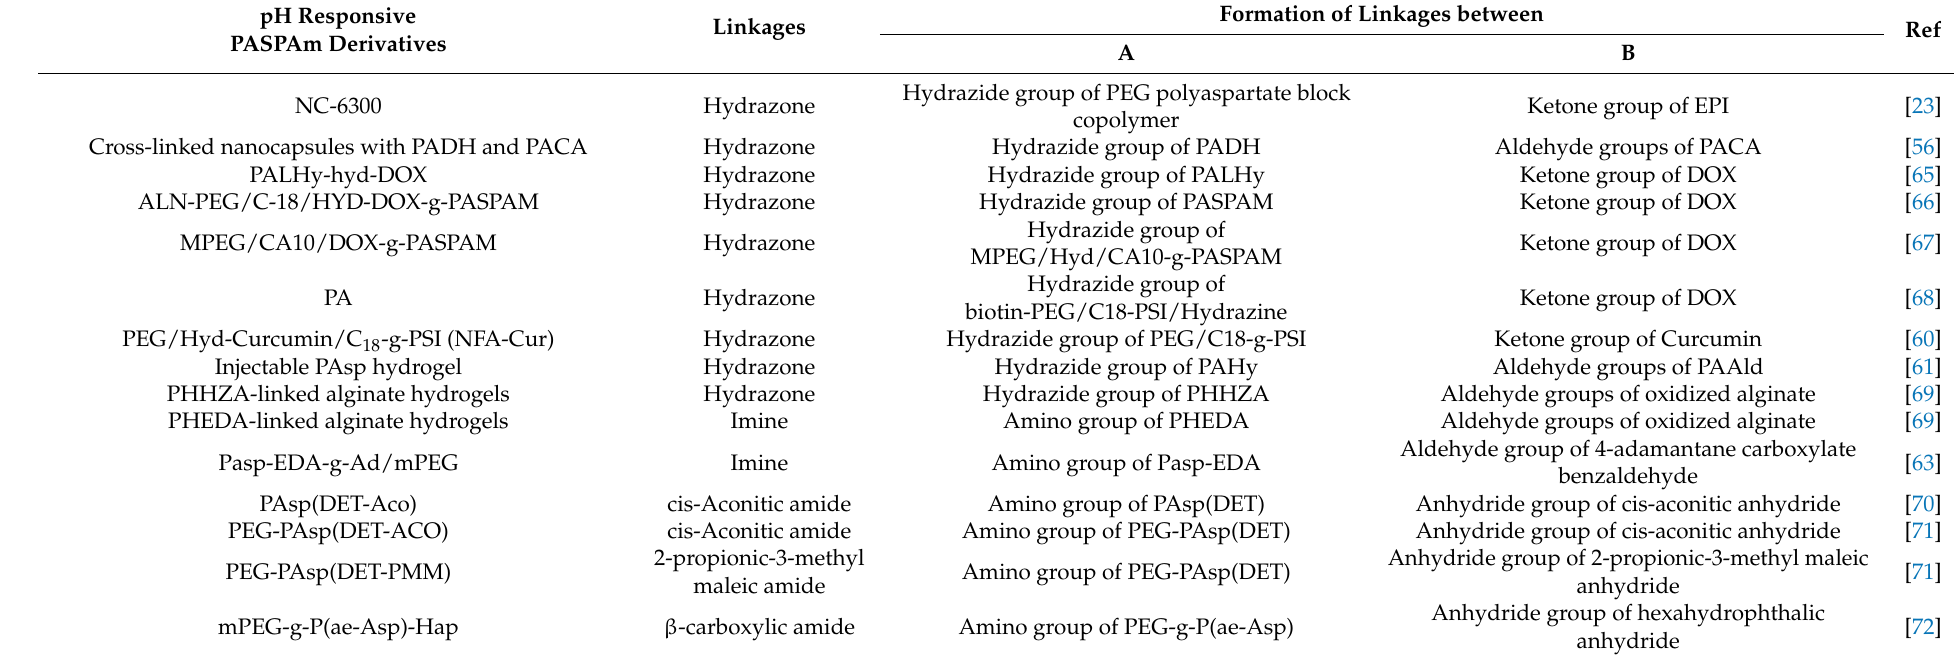
Table 2. A summary of pH-responsive PASPAm derivatives containing pH-cleavable